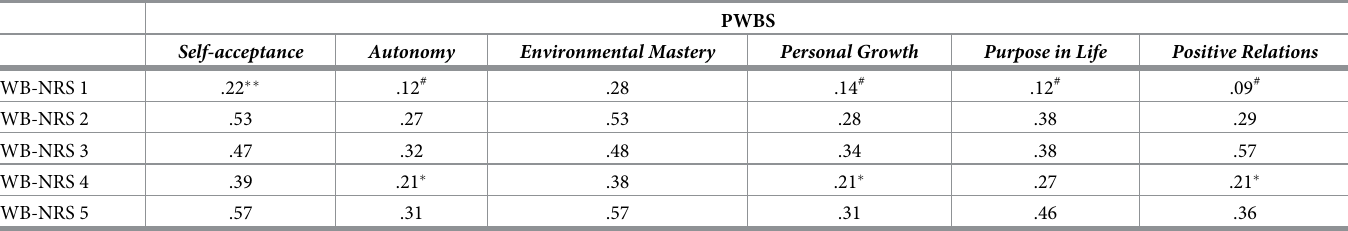
Table 5. Bivariate Bayesian correlates between the Well-being Numerical Rating Scales (WB-NRSs) and the Psychological Well-being Scales (PWBS). PWBS Self-acceptance Autonomy Environmental Mastery Personal Growth Purpose in Life